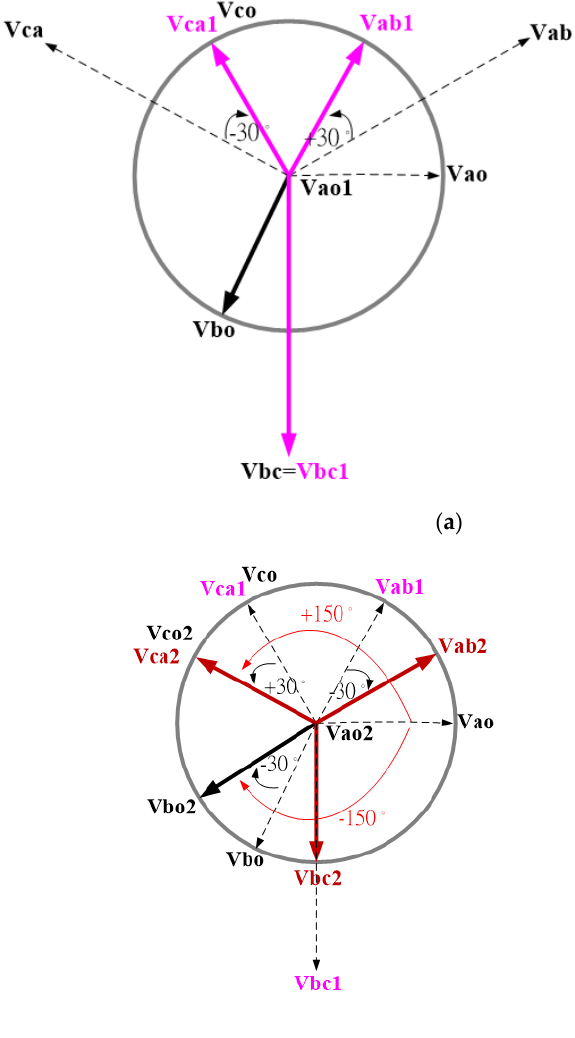
Figure 14. Voltage phasor diagram of fault-tolerant control when a fault occurs in the switch S a 1 + or S a 2 − ; ( a ) unadjusted voltage phase angle; ( b ) adjusted phase angle of the b -phase voltage such that it is 150° behind that of the a -phase voltage; adjusted phase angle of the c -phase voltage such that it is 150° ahead of that of the a -phase voltage.